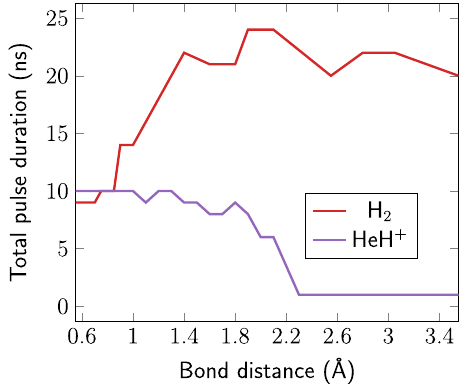
Fig. 3 Total pulse duration. Shown as a function of bond distance of H 2 and HeH + molecular systems. Square pulses were used to generate the ctrl-VQE molecular energies in Figs. 1 and 2. The shortest pulse duration at each geometry is plotted here.